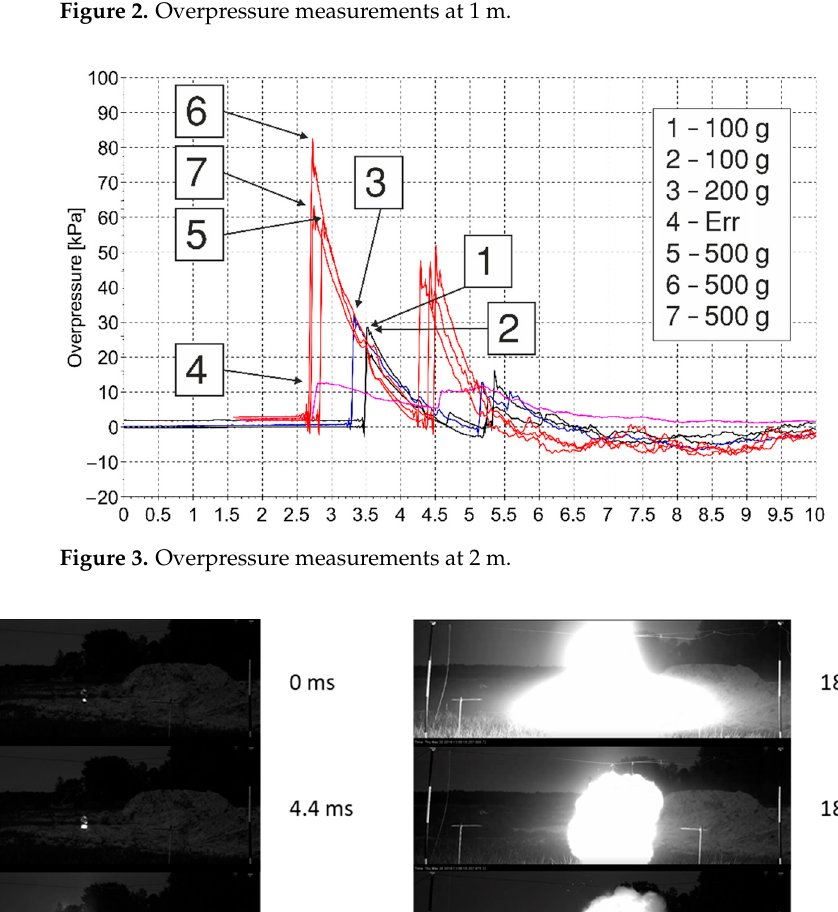
Figure 5. Image of the 500 g test (Test 7), in which burning Al particles (white arrows) were expelled. 2.2. Numerical Modelling Assumptions The computational model that was developed to simulate the energetics used a Car- tesian Adaptive Mesh (CAM) framework; this model simulates scenarios involving a blast, explosion, and release of materials (thus, CAMBER). CAMBER is an object-oriented framework that utilises a variety of material models and reaction laws. The mesh adapta- tion was used to resolve structures under severe deformation, and the code maps out the locations of gradients in properties [25]. In CAMBER, a finite-volume formulation is used. Various flux calculation schemes have been assessed and proven to be useful in multi- material flows [26]. The advection upstream splitting method (AUSM+) scheme was se- lected for its simplicity and robustness [27]; high spatial order is achieved via a monotonic upstream-centred scheme for conservation law (MUSCL) extrapolation with limiters. Given the small time steps required to resolve the evolving flow field, explicit time inte- gration was used. The code can be applied in 2D, 2D-axisymmetric, or 3D modes. 2.3. Governing Equation for Explosions The objective of this study was to formulate an approach to simulate explosions in- volving aluminium. The energetics used in the present research were for pure aluminium, so the reaction causing the energy release was as follows 4𝐴𝑙 + 3𝑂 ⟶ 2𝐴𝑙 (cid:2870) 𝑂 (cid:2871) .